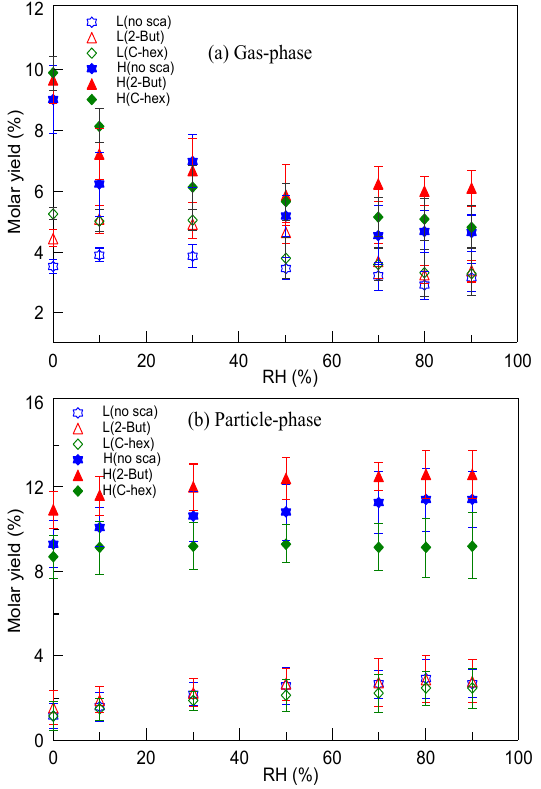
Figure 5. The variation of (a) gas-phase and (b) particle-phase high-molecular-weight peroxides’ molar yields with relative humid- ity (RH) at a low or high [O 3 ] / [limonene] ratio in the presence or absence of the OH scavenger (2-butanol or cyclohexane). L, low [O 3 ] / [limonene] ratio; H, high [O 3 ] / [limonene] ratio; No-sca, no scavenger; 2-But, 2-butanol; C-hex,